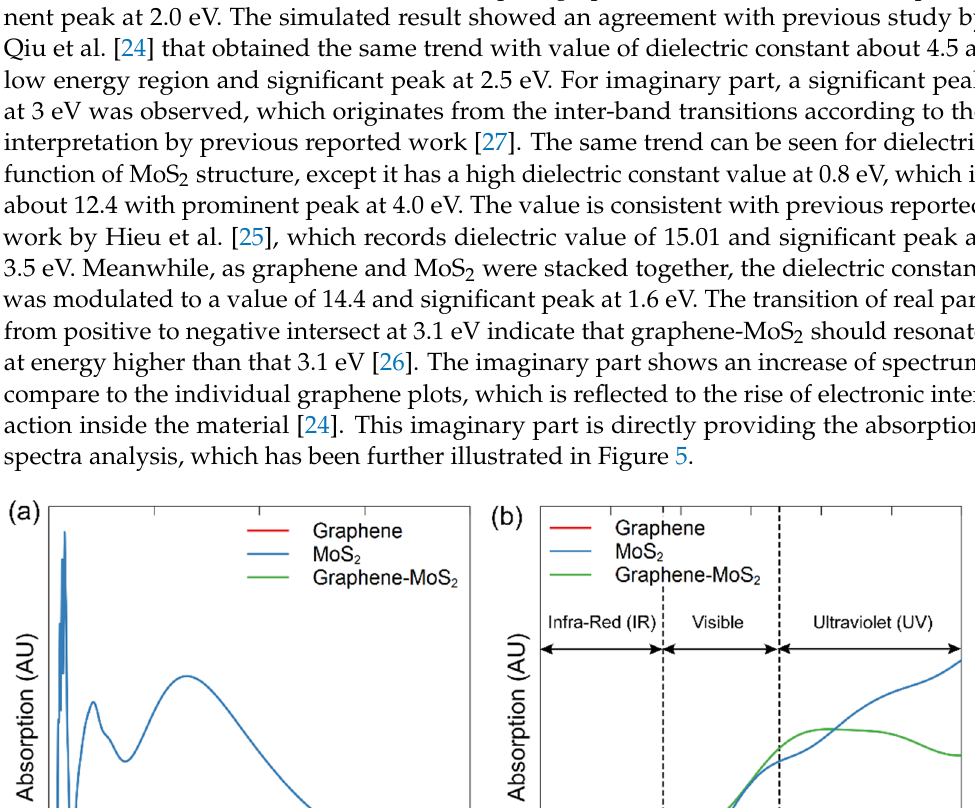
Figure 4. Theoretical real and imaginary part of dielectric function of simulated graphene, MoS 2 , and graphene-MoS 2 ( a ) real and ( b ) imaginary.